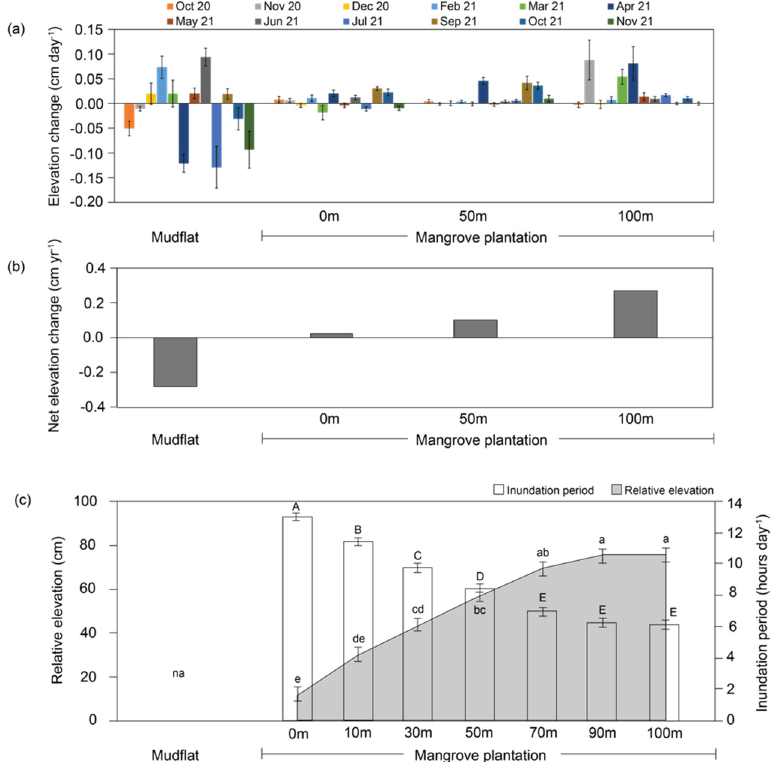
Figure 7. Average monthly elevation changes ( a ), net elevation changes ( b ), relative elevation and average inundation period ( c ) on the mudflat and at the distances along the transects from October 2020 to November 2021 (mean ± SE). The bar chart and grey area represent an average inundation period and relative elevation, respectively ( c ). The different letters indicate significant differences based on a post hoc test (pairwise comparison) at p < 0.05.